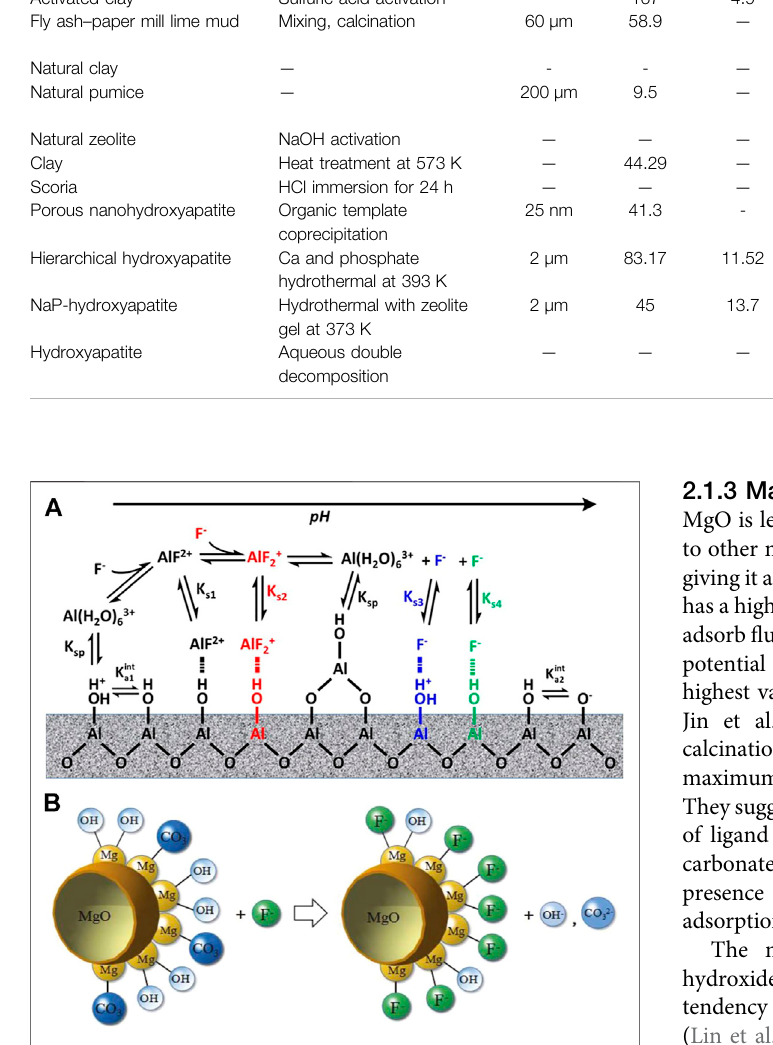
FIGURE 1 | Mechanism of fl uoride adsorption by activated alumina (A) (Lin et al., 2020) and MgO (B) (Zhang Y. et al., 2021).